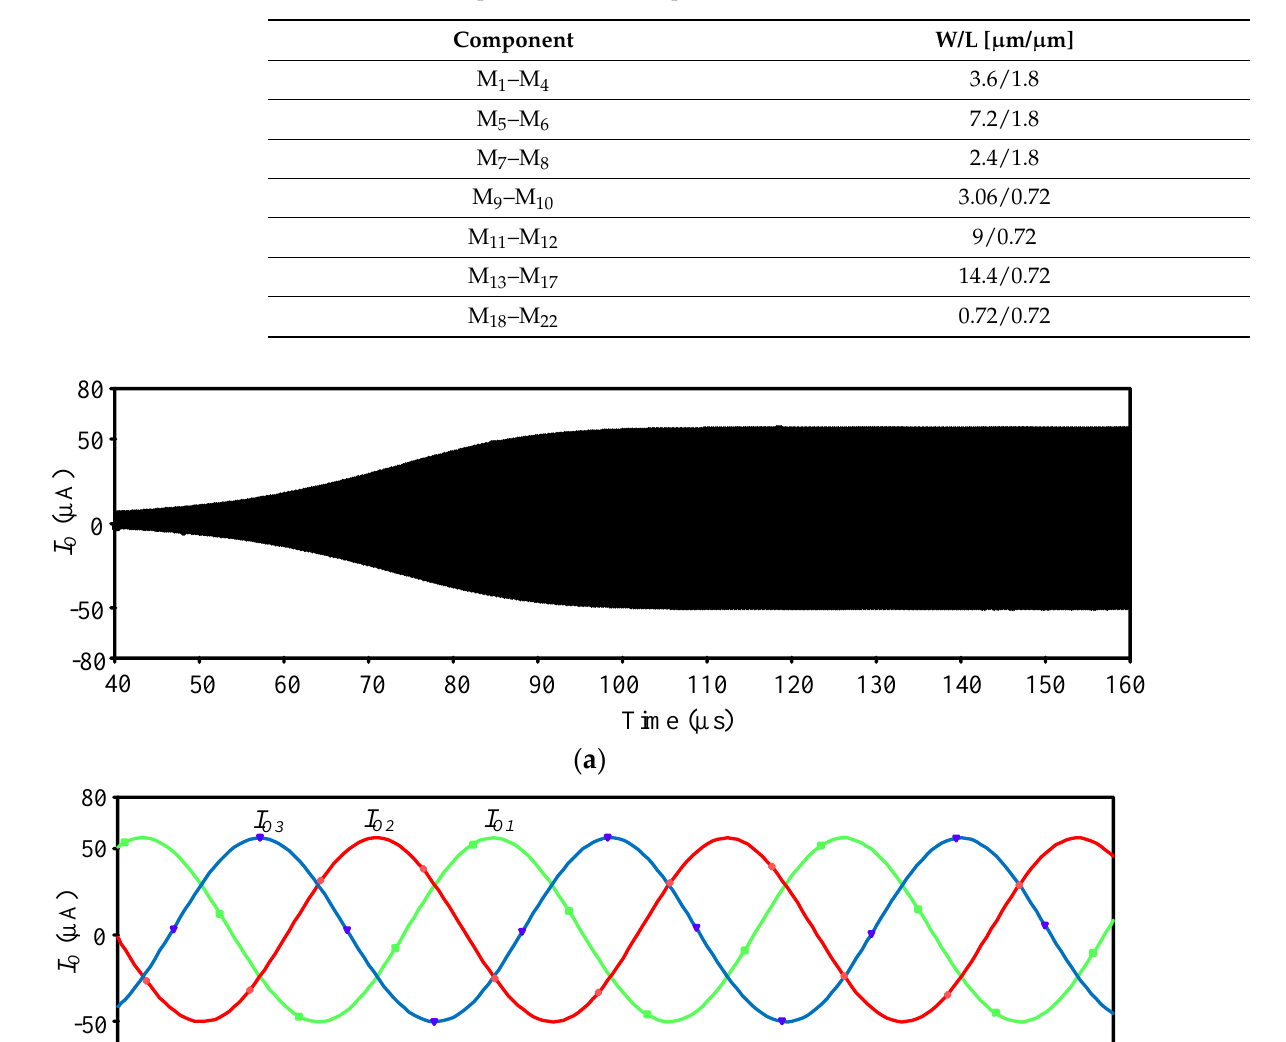
Table 2. Transistor aspect ratios and component values.